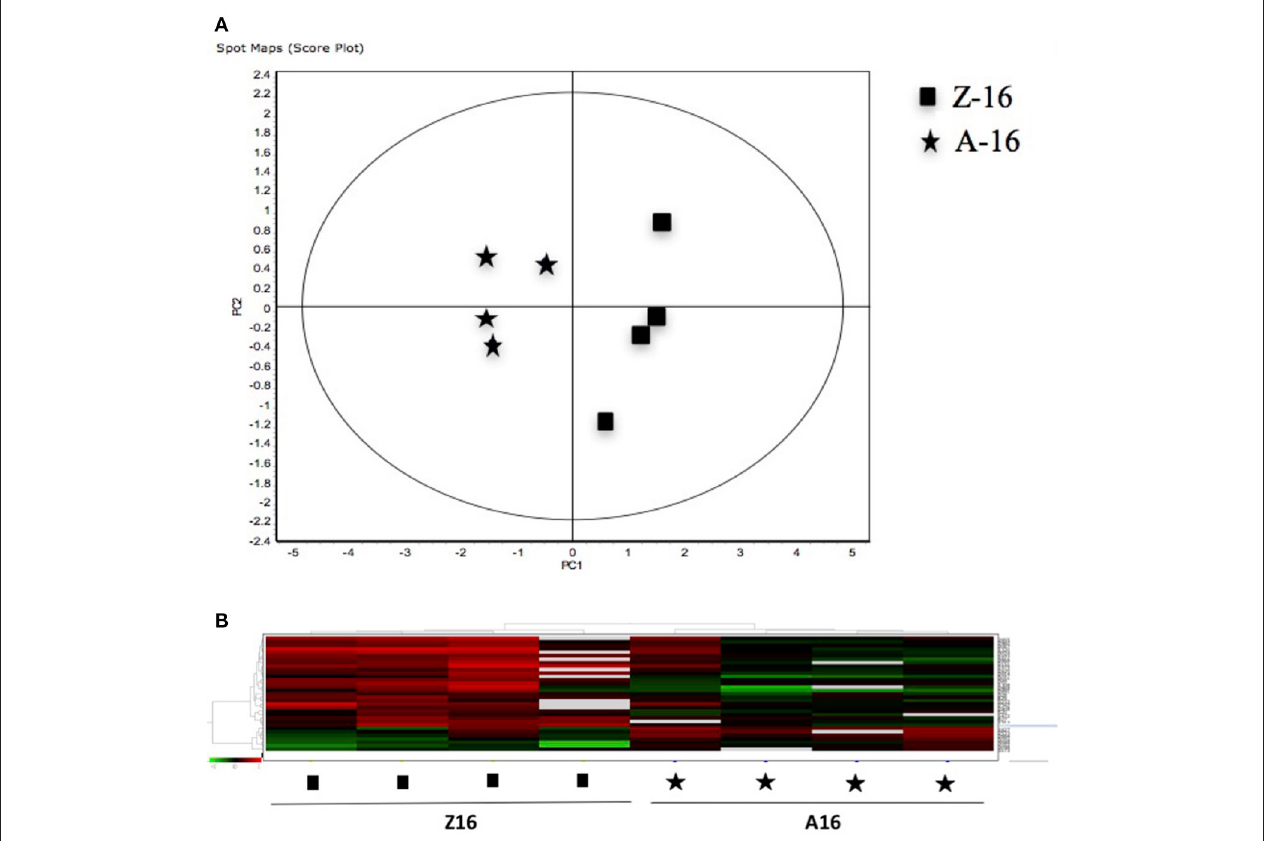
FIGURE 5 | (A) Principal Component Analyses (PCA) and (B) hierarchical cluster analyses of the protein spots (sub-sets) differentially expressed of paralarvae of Octopus vulgaris corresponding to the condition 4 (Z16 vs. A16) considered as function of dietary group and age (details in Supplementary Table 3). % of variance explained: PC1 = 72.6; PC2 = 8.